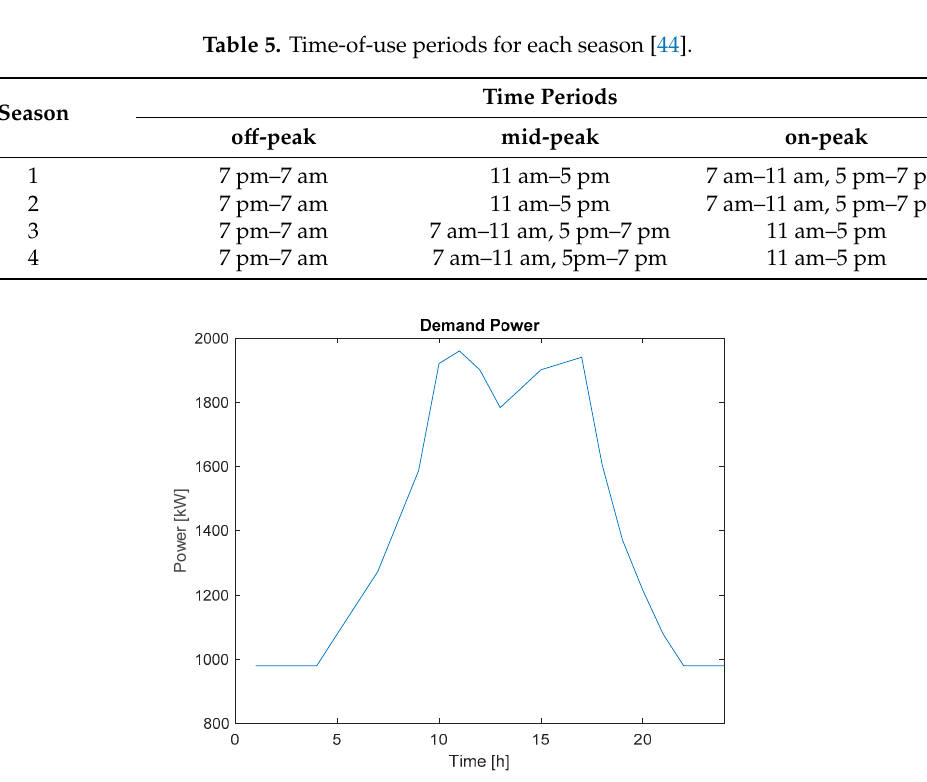
Figure 1. Load requirements with peak load of 2000 kVA with industrial demand curve [45].